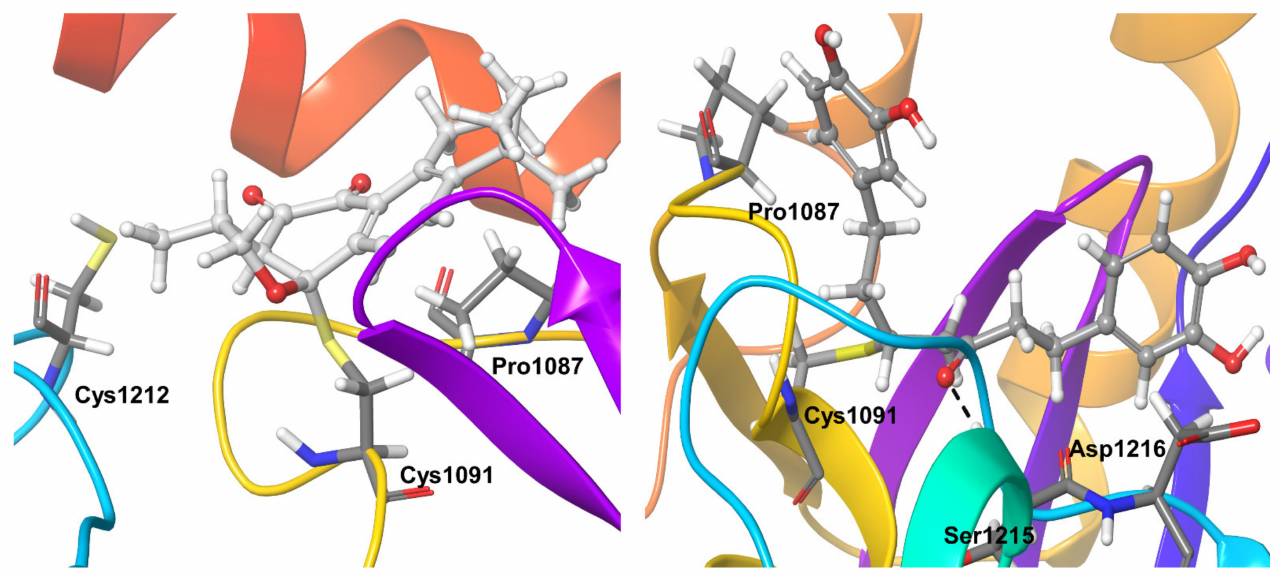
Figure 8. Stable inhibitor-protein interactions were observed during MD refinement simulations of top poses of Compound 3 ( left ) and 4 ( right ) with OTUB1. The inhibitors are shown in ball and stick representation, stable and moderately stable ligand-protein interactions are given as thick tubes, and flexible interactions (during less than 30%) are shown as thin